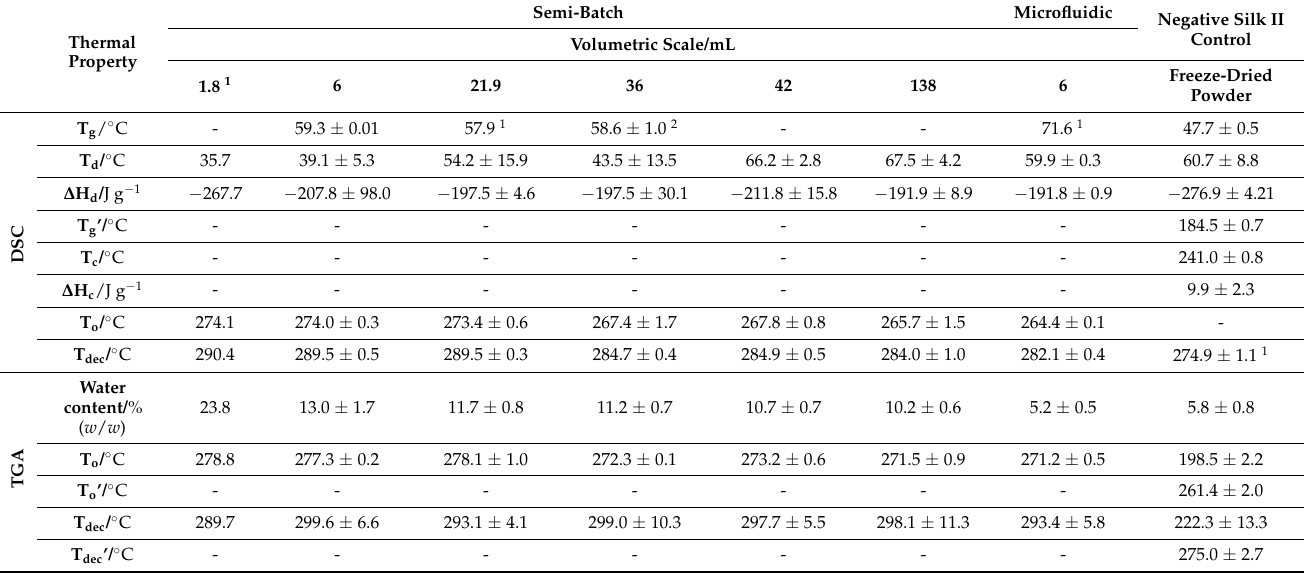
Table 3. First-cycle thermal properties of silk nanoparticles produced by varying volumetric scale. Semi-Batch Microfluidic Negative Silk II ControlVolumetric Thermal Property